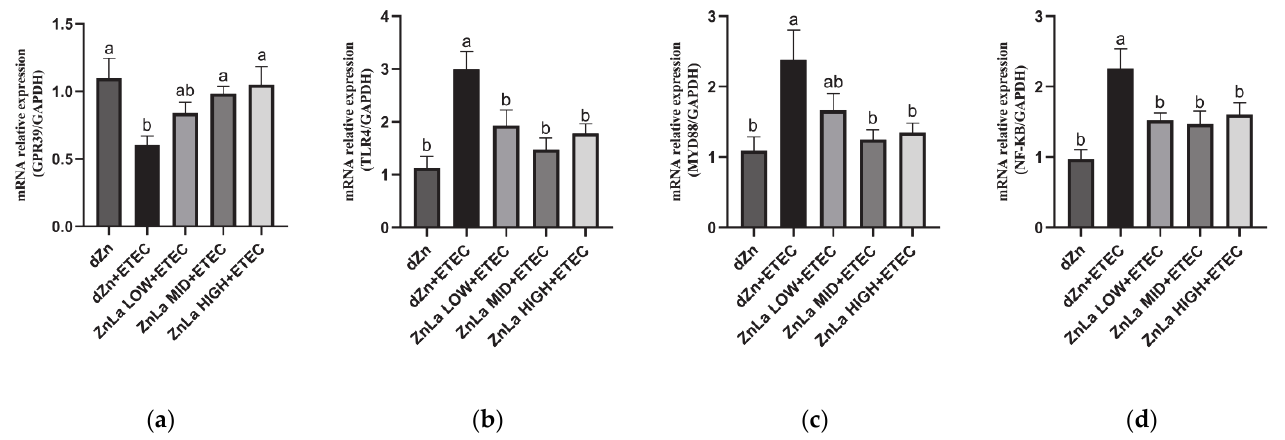
Figure 5. Effect of ZnLa on TLR4/MYD88/NF- κ B signaling pathway in mice with ETEC challenge. Relative mRNA expression of ( a ) GPR39 , ( b ) TLR4 , ( c ) MYD88 , and ( d ) NF- κ B in the jejunum. The data are expressed as mean ± s.e.m (n = 9), and different lowercase letters in each group show significant differences ( p < 0.05).